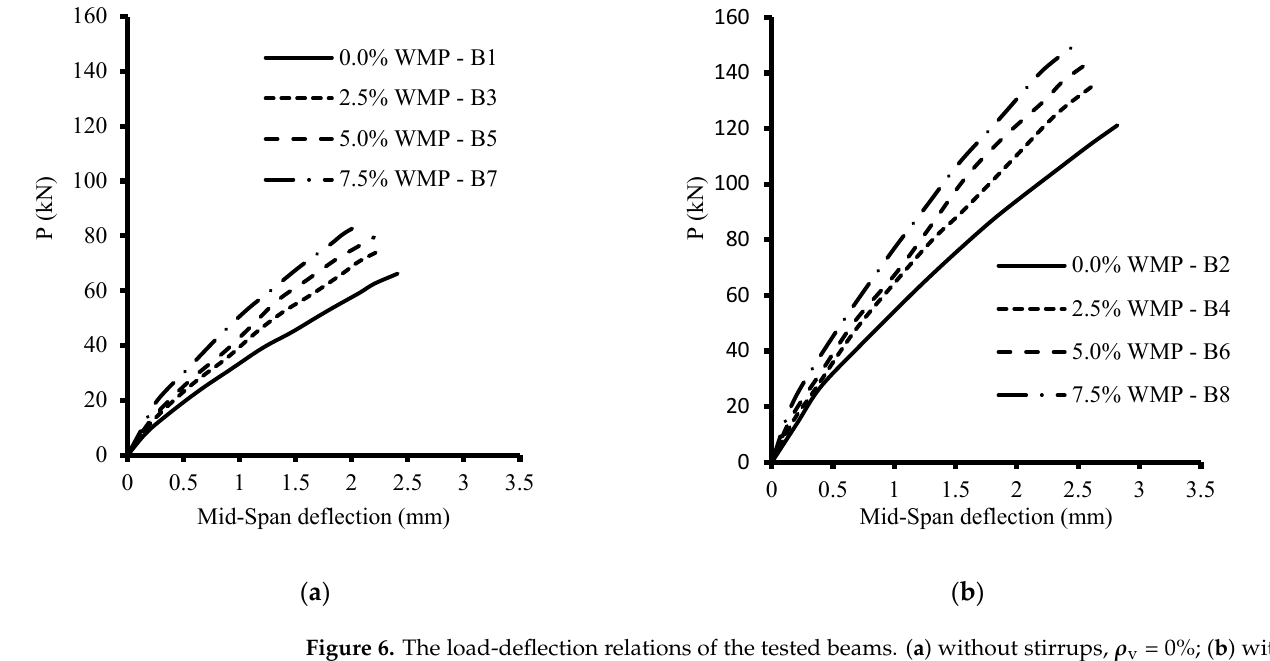
Figure 6. The load-deflection relations of the tested beams. ( a ) without stirrups, ρ v = 0%; ( b ) with stirrups, ρ v = 0.47%.